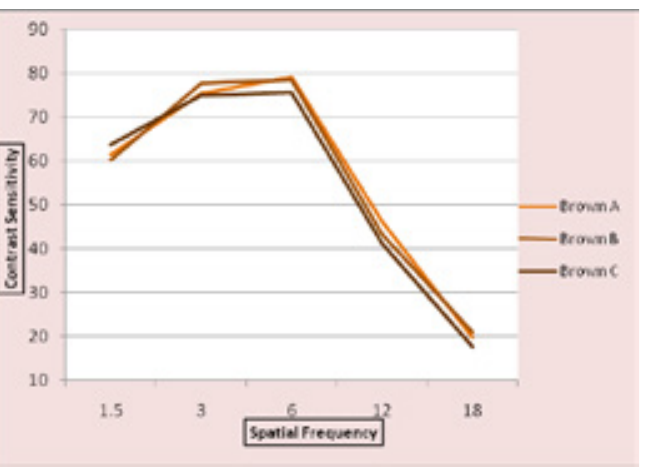
Figure 2: Contrast sensitivity functions for the varying densi- ties (A, B and C) of the grey tint